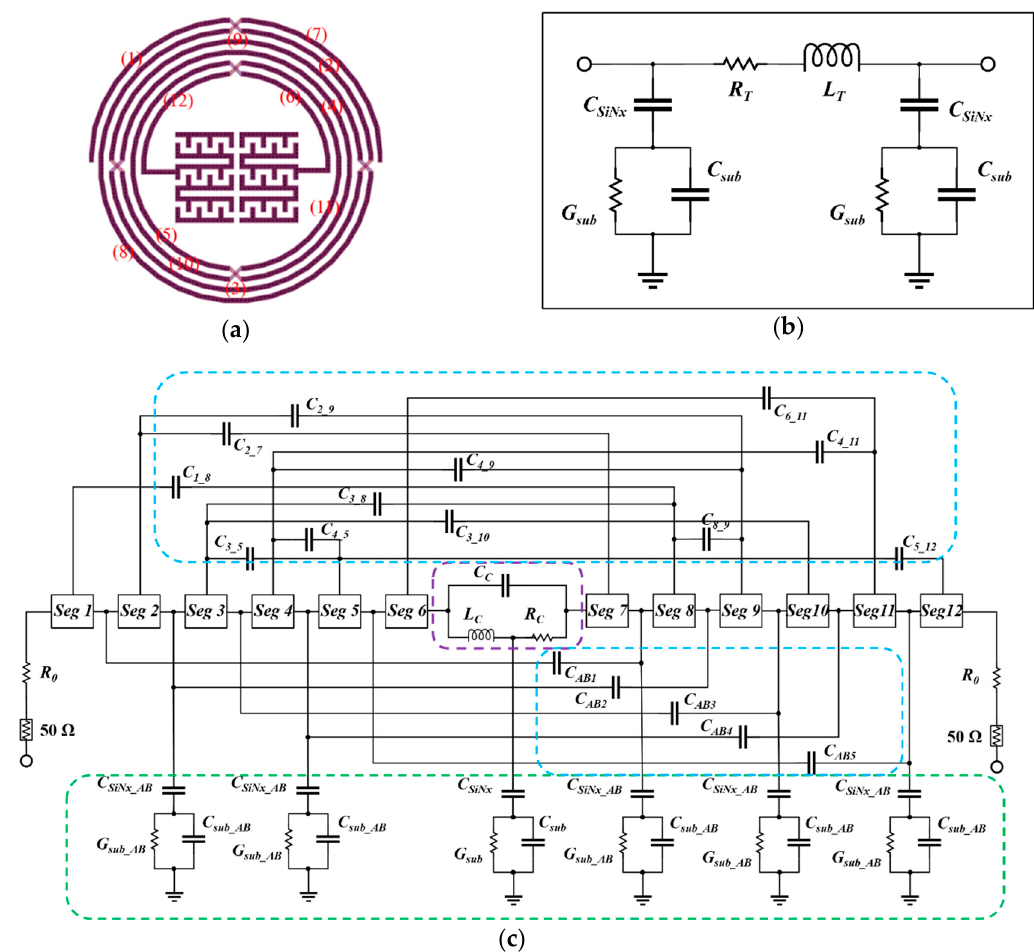
Figure 2. ( a ) Number of segment boxes in the proposed BPF; ( b ) π -type lumped-element model inside the segment box; ( c ) equivalent circuit model of the proposed BPF.